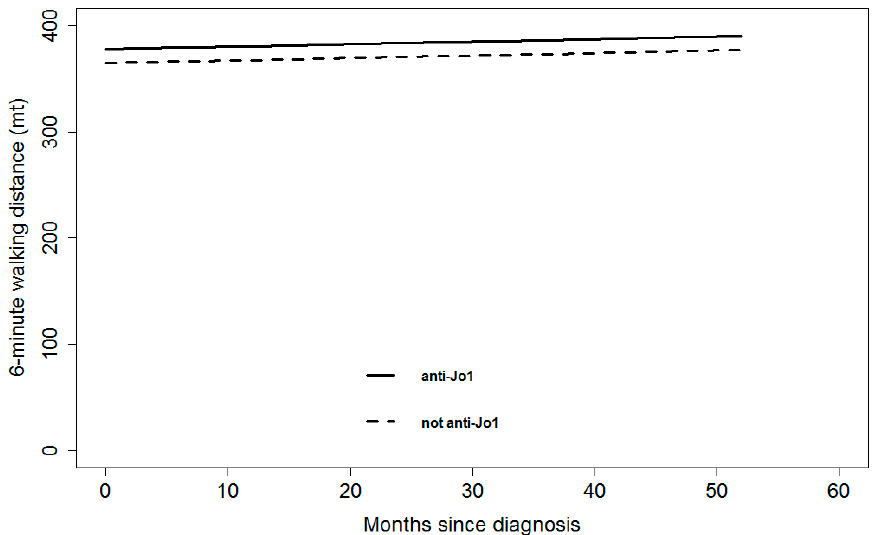
Figure 2. Model-based predicted value of 6-min walking distance by time and anti-Jo1 for a patient 60 years old, anti-SSA/Ro52+ negative, acute onset, diagnosis within 12 months from symptom onset, and without immunosuppressant treatment. A continuous line represents anti-Jo1 patients; dashed lines represent non anti-Jo1 patients.